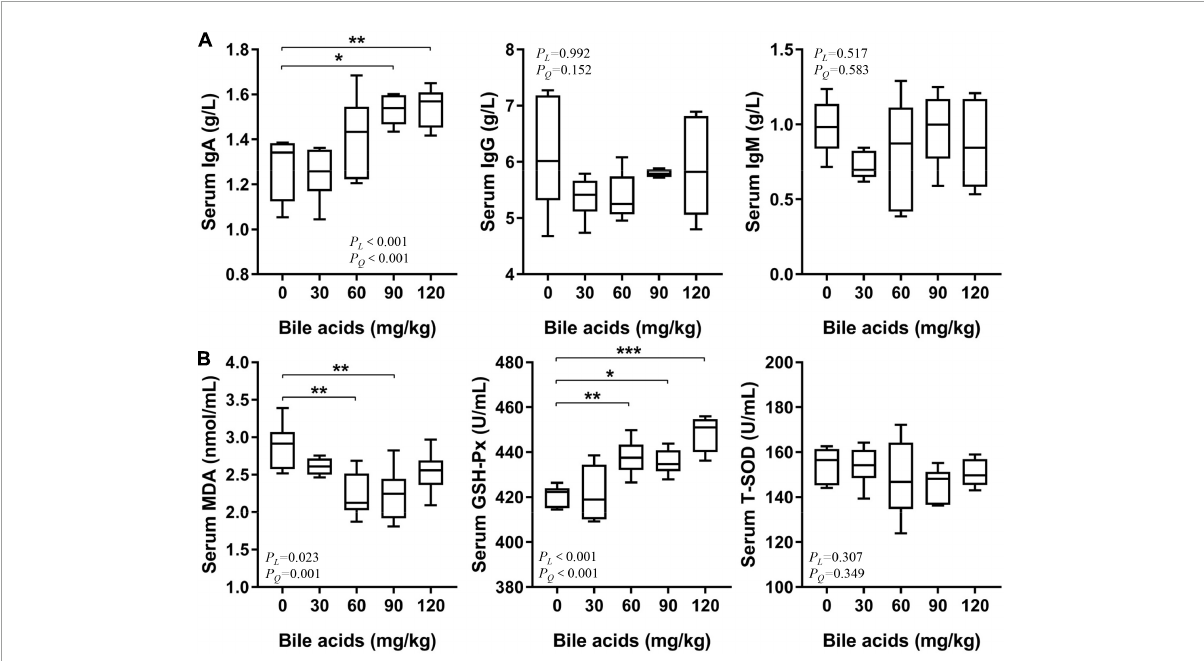
FIGURE4 Porcine bile acids enhanced serum immunity and antioxidant capacity of laying hens. IgA/G/M, immunoglobulin A/G/M. MDA, malondialdehyde. GSH-Px, glutathione peroxidase. T-SOD, total superoxide dismutase. P L , linear P -value. P Q , quadratic P -value. (A) Porcine bile acids enhanced serum immunity of laying hens. (B) Porcine bile acids enhanced serum antioxidant capacity of laying hens. (A,B) Each box represents the mean value of six hens each treatment ( n = 6). Whiskers represent maximum and minimum. Different at P < 0.05 is marked as *, P < 0.01 is marked as **, and P < 0.001 is marked as